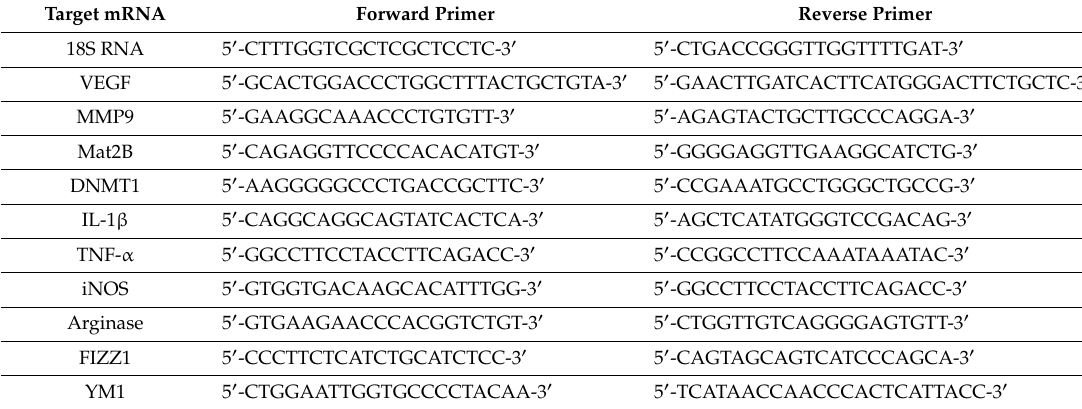
Table 1. Primers used for RT-qPCR.